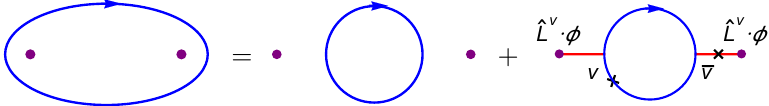
Figure 18 . Gluing two copies of the diagrams in (cid:12)gure 17 by conjugation. Here we have dropped diagrams on the l.h.s. that vanish by the tadpole condition (see next